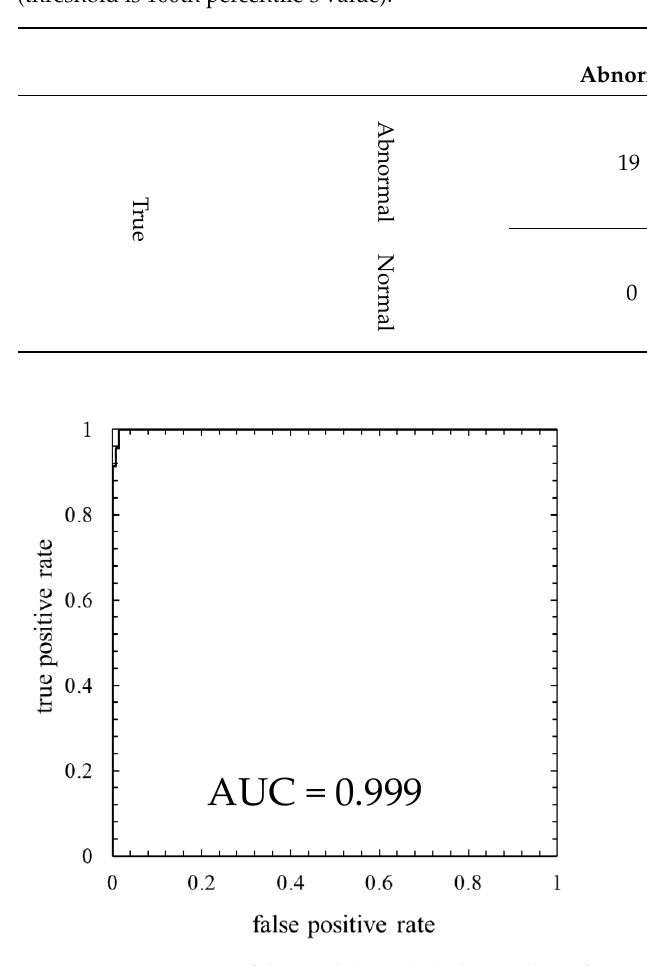
Figure 12. ROC curve of the model in which the number of mixture components K was 128 (threshold is 100th percentile’s value). Table 6. Confusion matrix of the model in which the number of mixture components K was 128 (threshold is 100th percentile’s value).